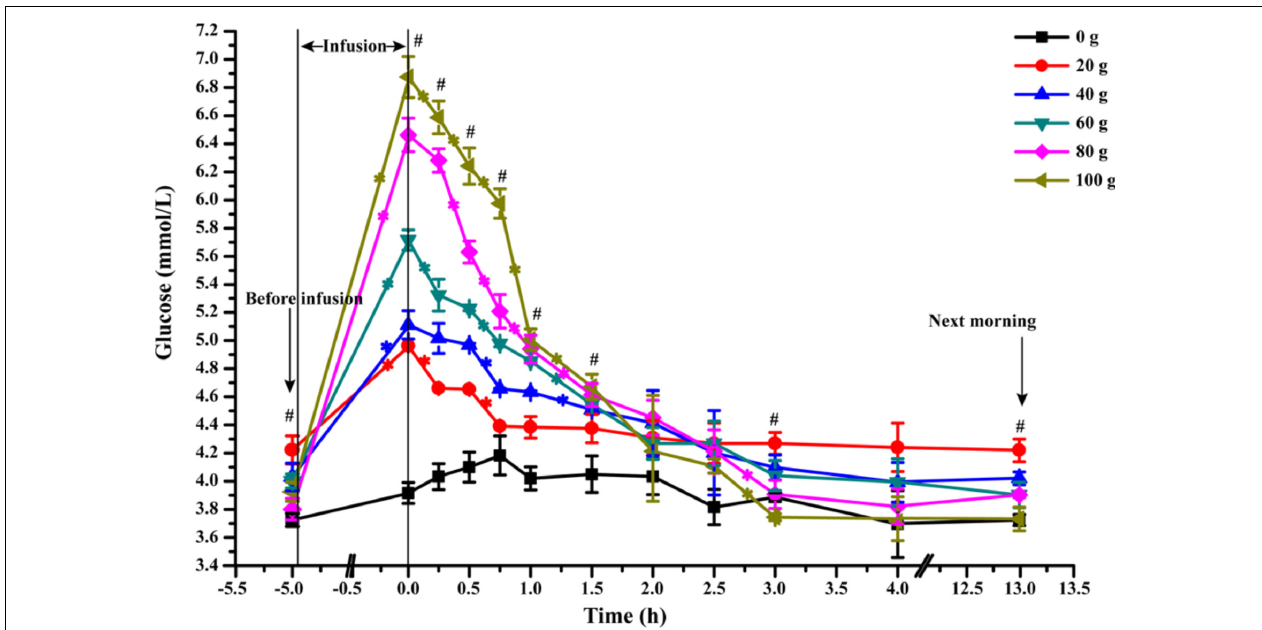
FIGURE 2 | Dynamic changes of artery glucose concentration after infusion of different doses of glucose (0–100 g/d) through external pudendal artery. The 0 time in the X axis represents the end time of infusion. “ ∗ ” represents significant difference in the time effect in each treatment, and “ # ” represents significant difference in the treatment effect at individual time points ( P <